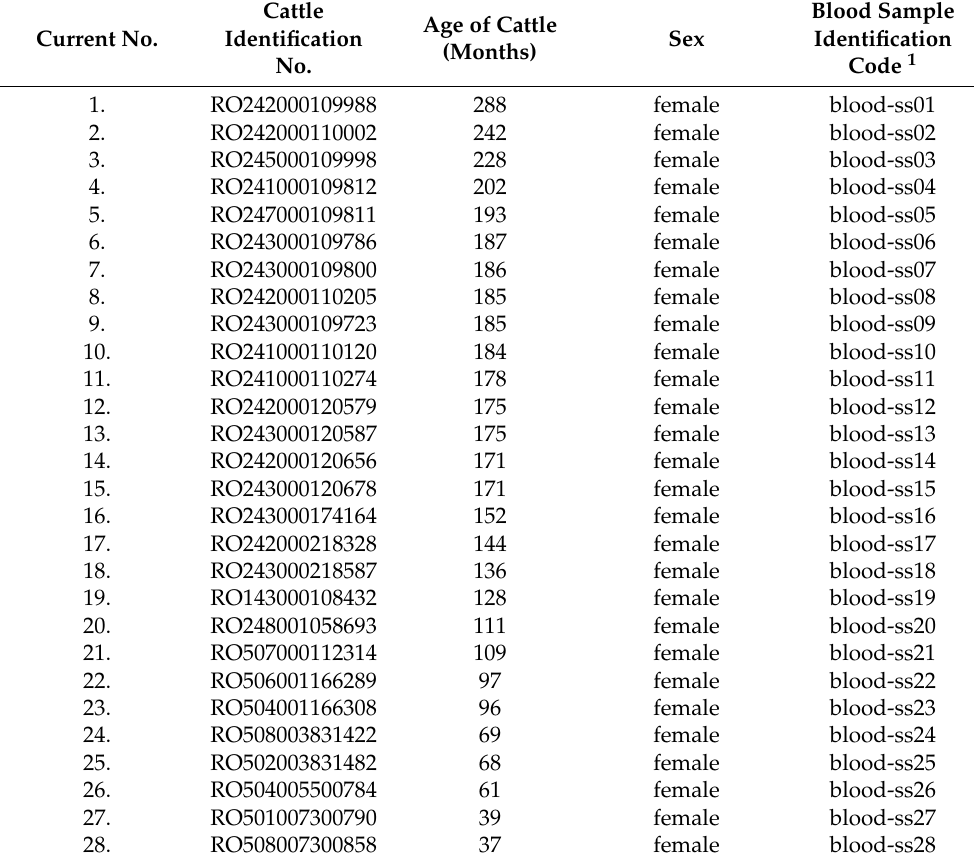
Table 1. Information on Grey Steppe population